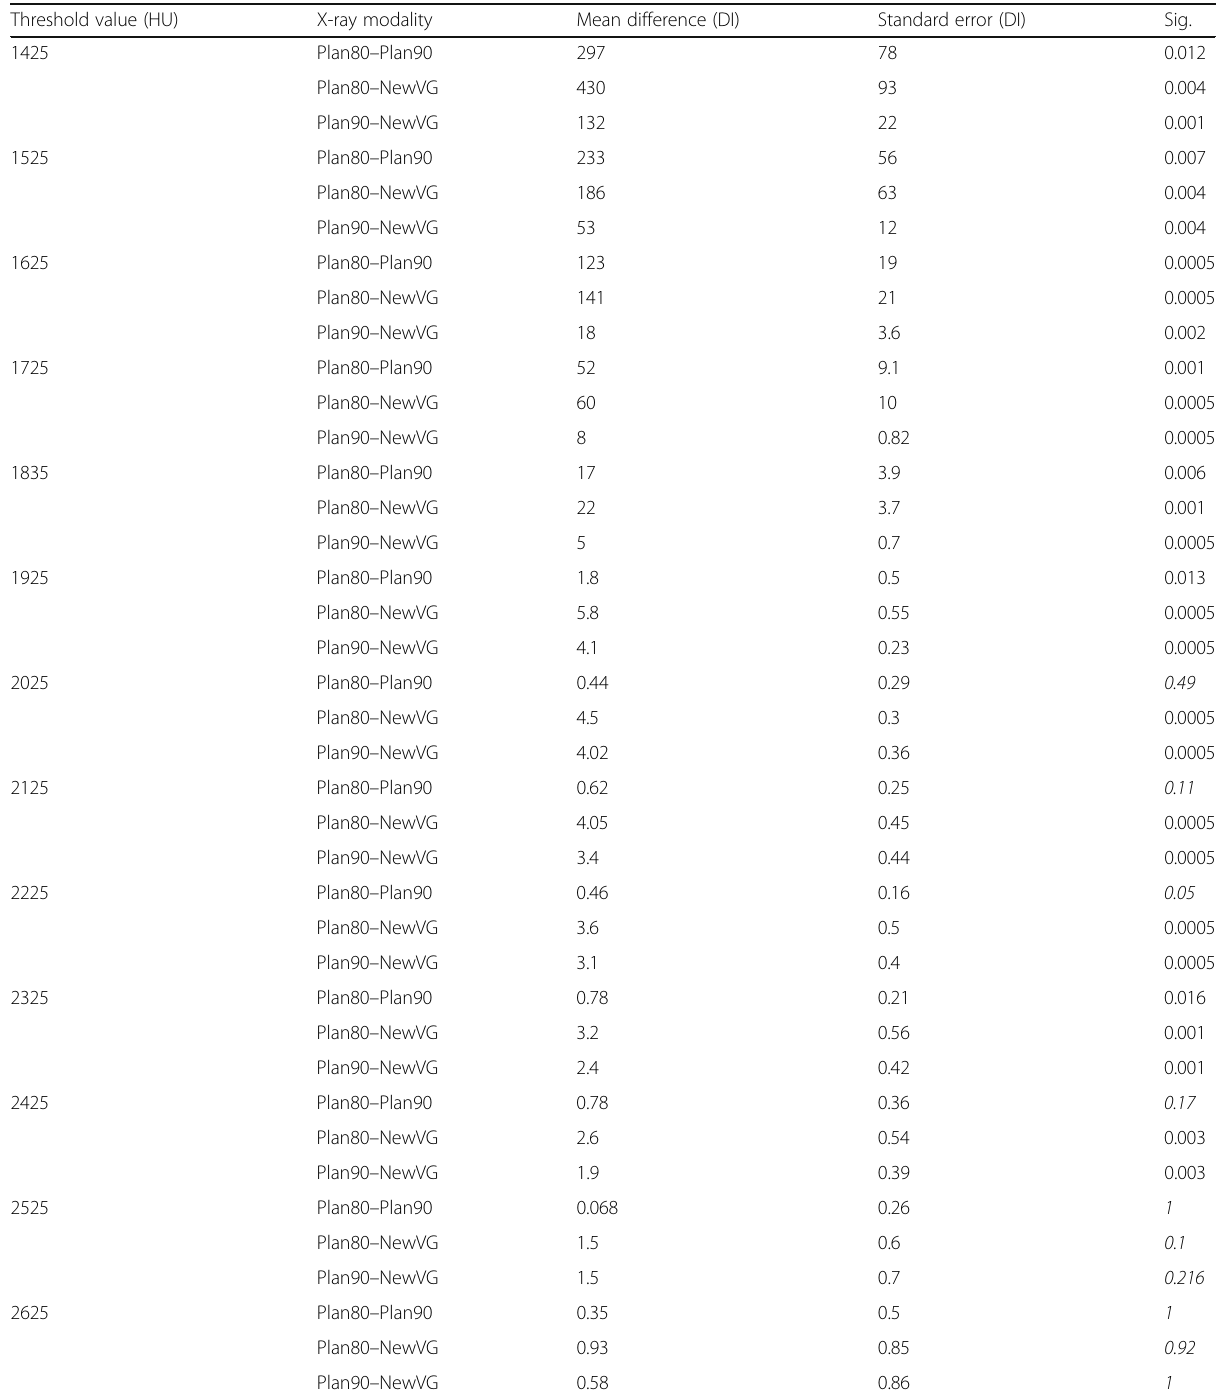
Table 3 Simple main effects of x-ray modality on error Threshold value (HU) X-ray modality Mean difference